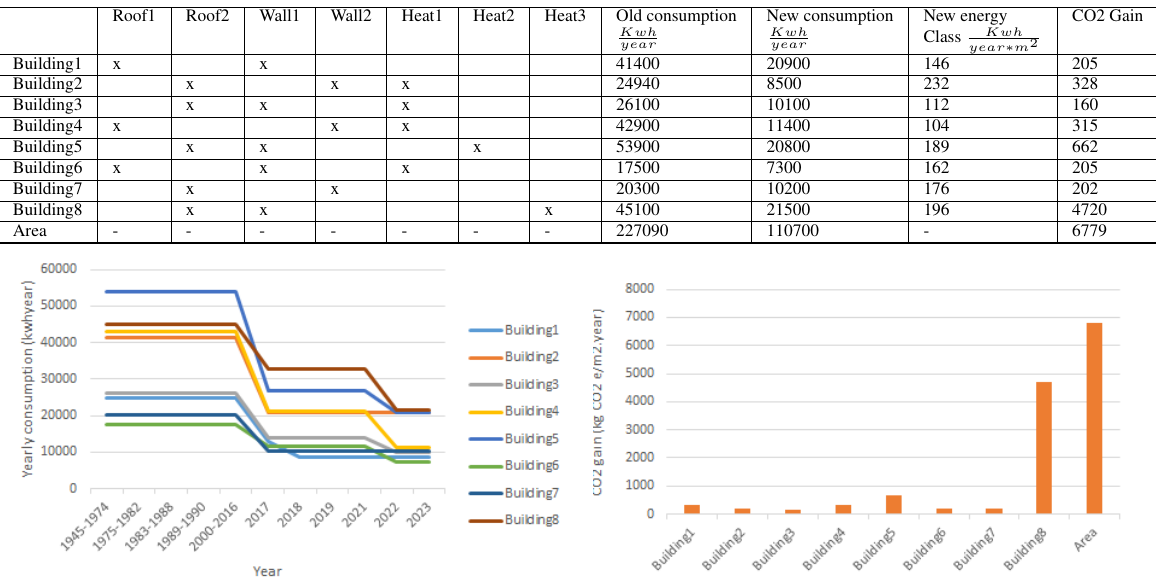
Figure 7. Influence of energy renovation measures on energy efficiency class and CO2 emissions on a building Table 6. Influence of energy renovation on an Area